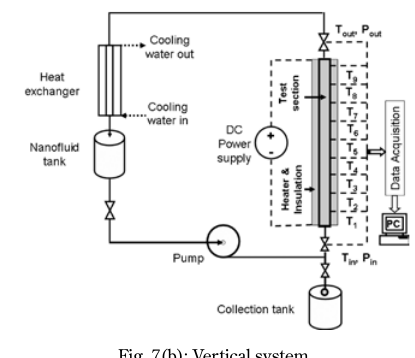
Fig. 7(b): Vertical Fig. 7 Experimental systems for forced convective heat transfer studies.